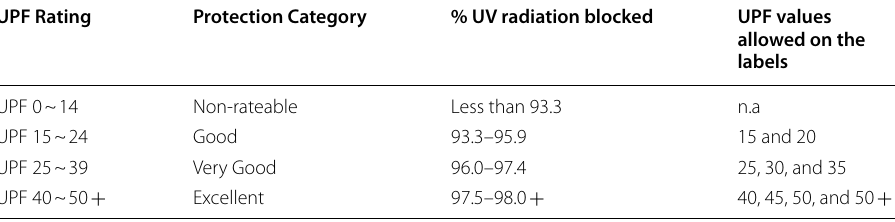
(Gorjanc et al., 2014; Narantuya & Ahn, 2020; Sungrubbies, 2022; “Sun protective clothing,”